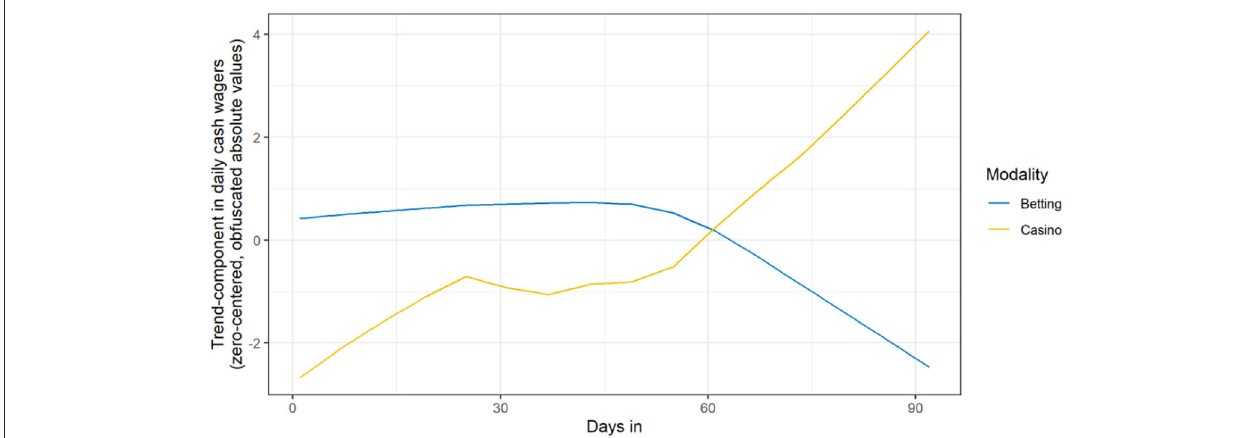
FIGURE 3 | Trends in online betting and casino activity. For visualization purposes, each time series was zero-centered by subtracting their respective mean, preserving absolute